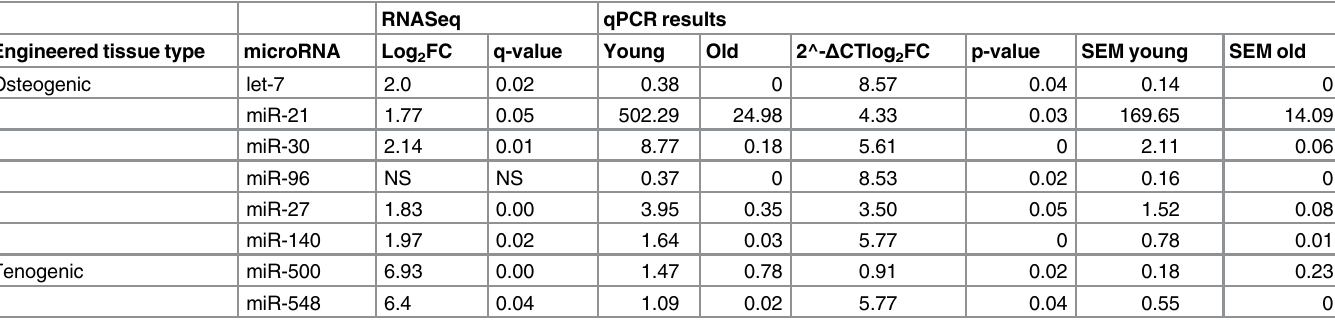
Table 4. The differential expression of several miRs was validated using qPCR. Engineered tissue type